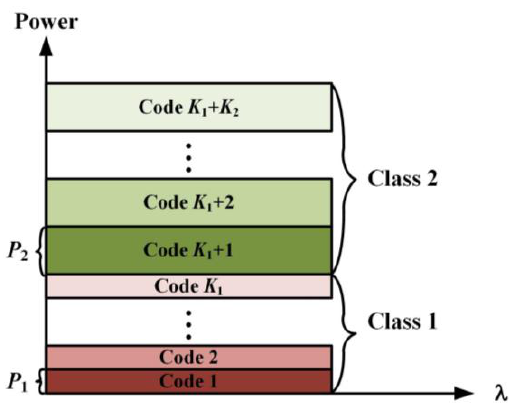
Figure 1. User classification and power distribution in the proposed differential service system with spectral amplitude coding (SAC) optical code-division multiple-access (OCDMA).